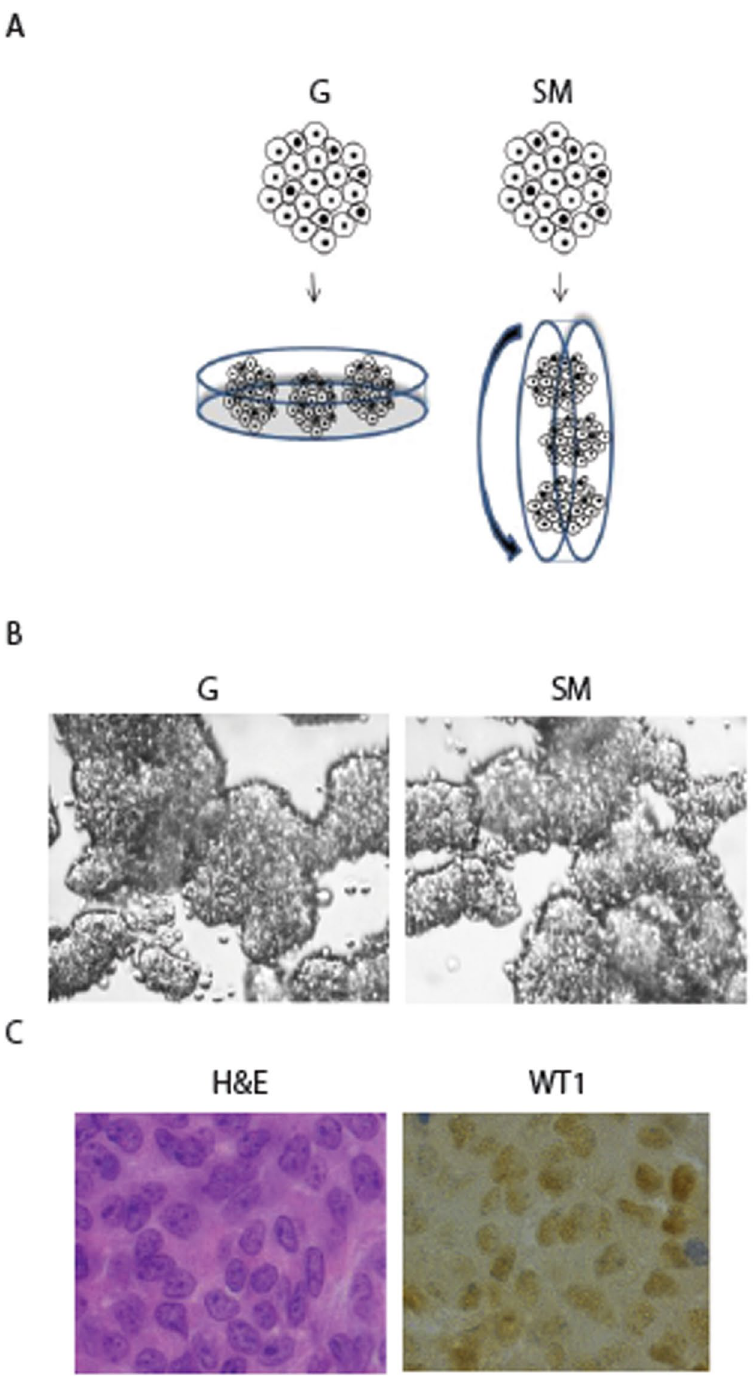
Figure 1. SM induces Sertoli cell spheroids. ( A ) Schematic representation of 3D Sertoli cell culture at unit gravity (G) and in Rotary Cell Culture System (SM). ( B ) Representative images of Sertoli cell spheroids after 48 hours of culture at G or under SM. ( C ) Representative sections of Sertoli cell spheroids immunostained with WT1 antiboby, a marker of Sertoli cells and stained with